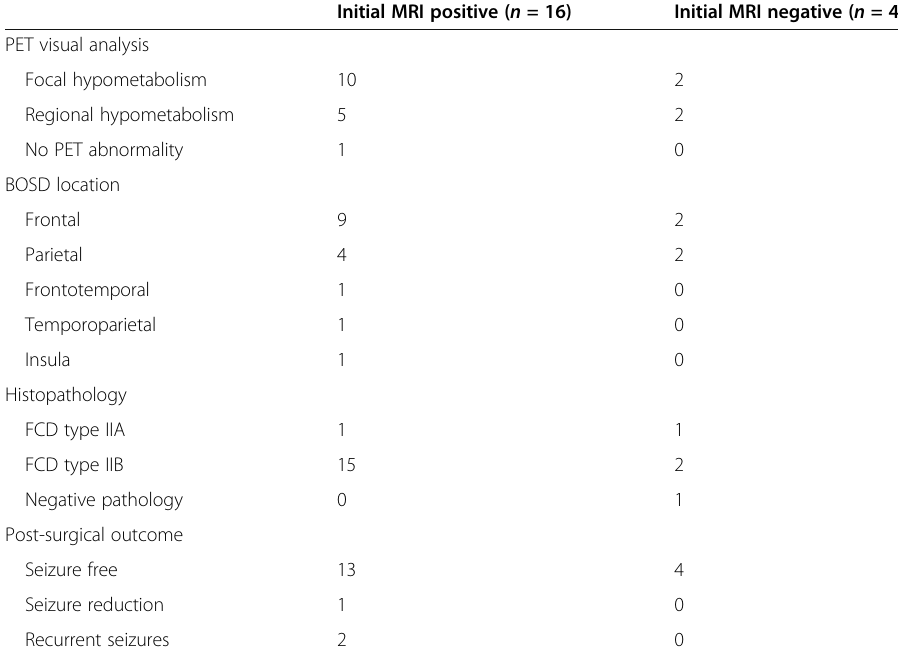
Table 2 PET data in relation to MRI and surgical